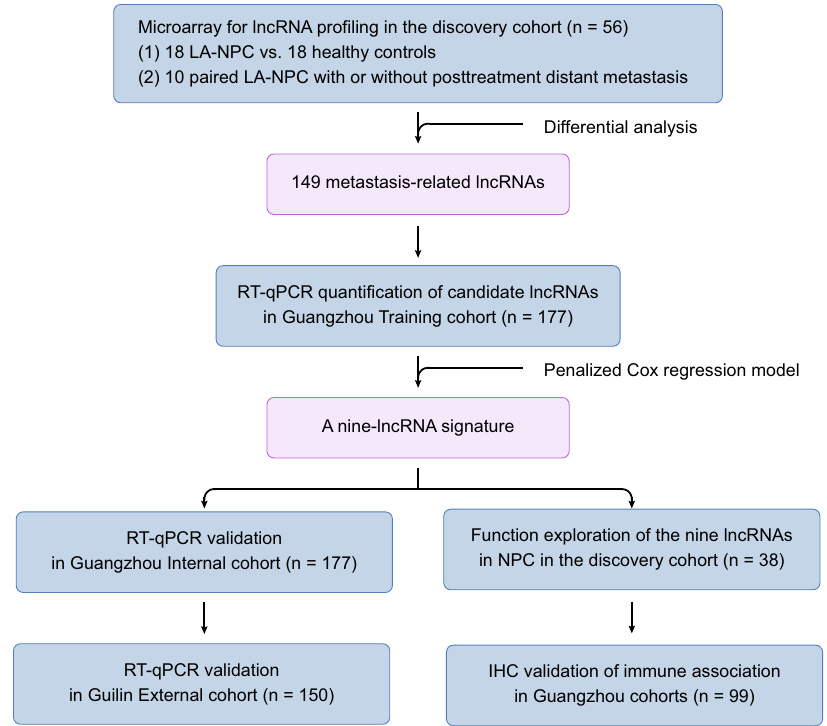
Fig. 1 Study design. This fi gure shows the work fl ow of the study. LA-NPC locoregionally advanced nasopharyngeal carcinoma, RT – qPCR quantitative reverse transcription